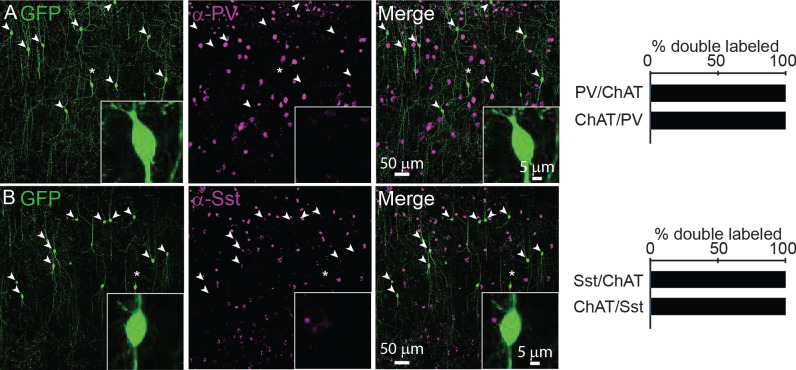
Cortical ChAT+ neurons do not express Parvalbumin or Somatostatin.(A) Cortical ChAT+ neurons, labeled by injecting AAV(8)-DIO-EGFP into the frontal cortex of Chatires-Cre mice, do not co-label with immunostained PV (n = 1 ChAT+,PV+ of 180 CHAT+ and 576 PV+ neurons from 3 Chatires-Cre mice). (B) Cortical ChAT+ neurons, labeled as above, do not co-label with immunostained Sst (n = 2 ChAT+/Sst+ of 360 ChAT+ and 1016 Sst+ neurons from 3 Chatires-Cre mice). Arrowheads indicate GFP-expressing ChAT+ neurons and asterisks indicate cells shown in the insets.